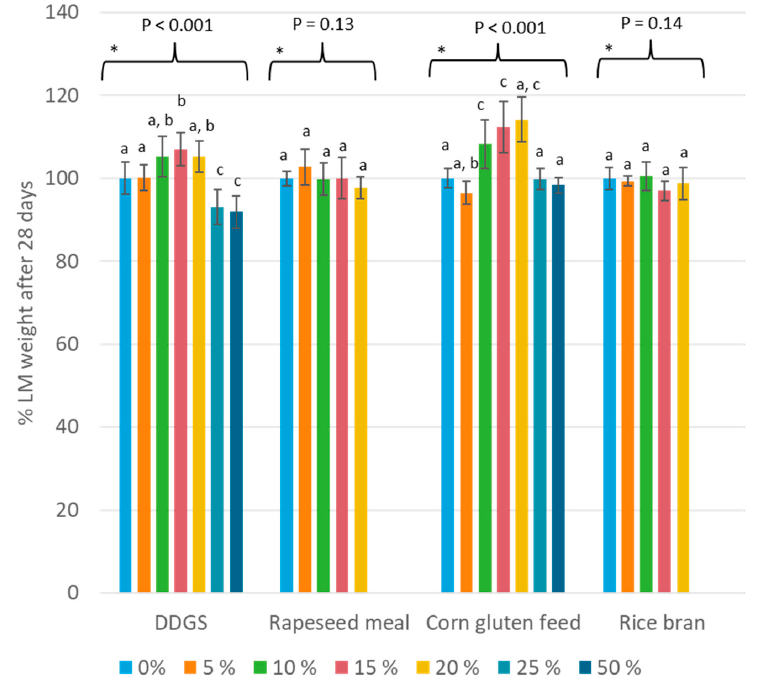
Figure 4. Larval weight after 28 days of rearing for the mixed diets. The bars indicate the percentage of wheat middlings that was replaced by the side-stream, where 0% refers to the reference diet ( n =